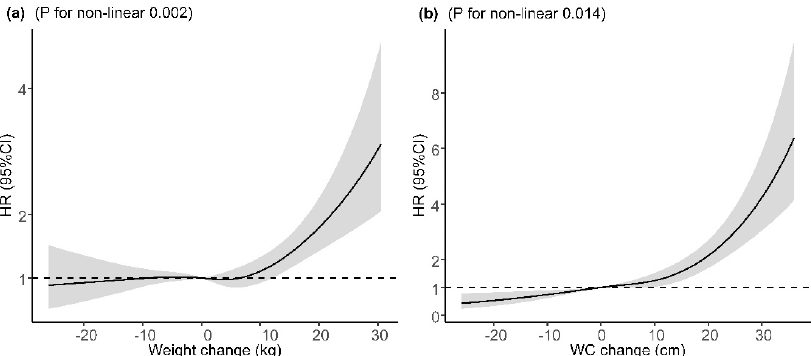
Figure 2. Dose–response relation between weight/WC change and incident T2DM. ( a ) Dose–response relation between weight change and incident T2DM; ( b ) dose–response relation between WC change and incident T2DM. Adjusted for age (continuous variable), sex, ethnicity, education, marriage, occupation, smoking status, alcohol use, physical activity, history of hypertension, history of dyslipidemia, IGR, and baseline BMI value (in the analyses of weight change) or baseline WC (in the analyses of WC change). HR, hazard ratio; 95% CI, 95% confidence interval; WC, weight circumference.